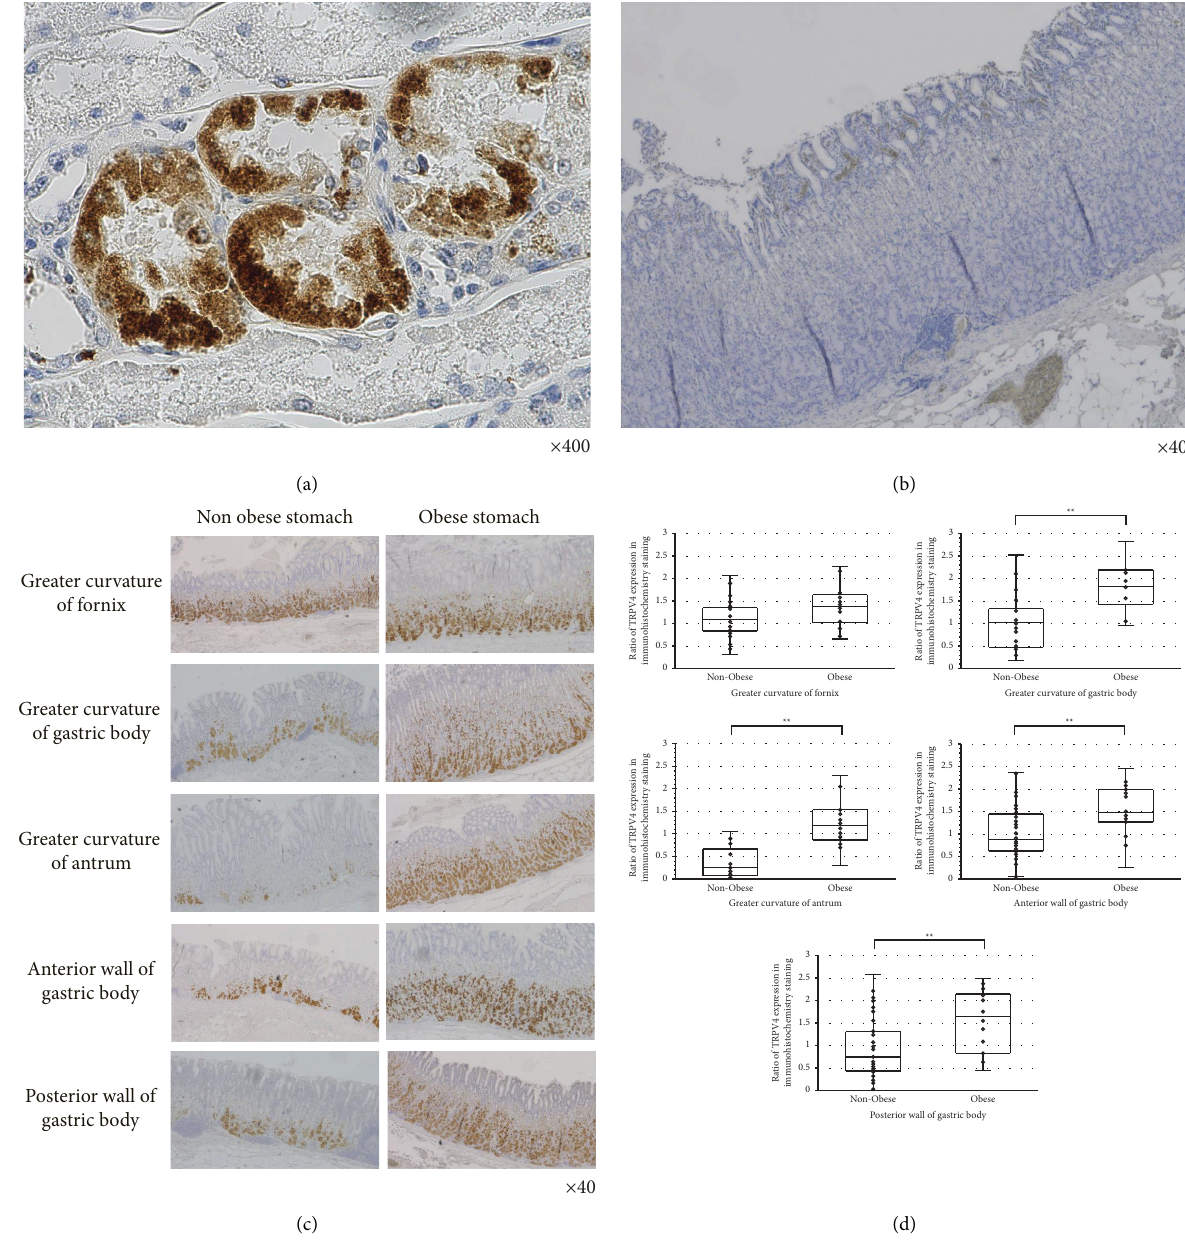
Figure 2: Comparison of stained areas between nonobese and obese cases. (a) Renal tissues were used as a positive control for TRPV4- immunostaining. (b) For the negative control, tissues were subjected to immunostaining without the primary antibody. (c) Immunostaining of the nonobese and obese stomach. (d) Comparison of stained areas in tissue samples collected from patients with and without obesity. Lines within the boxes represent median values; upper and lower lines of the boxes represent 25th and 75th percentiles, respectively; upper and lower bars outside the boxes represent the maximum and minimum, respectively ( ∗∗ p < 0 . 01). Table 1: TRPV4 immunostaining in the stomach of patients with and without obesity.